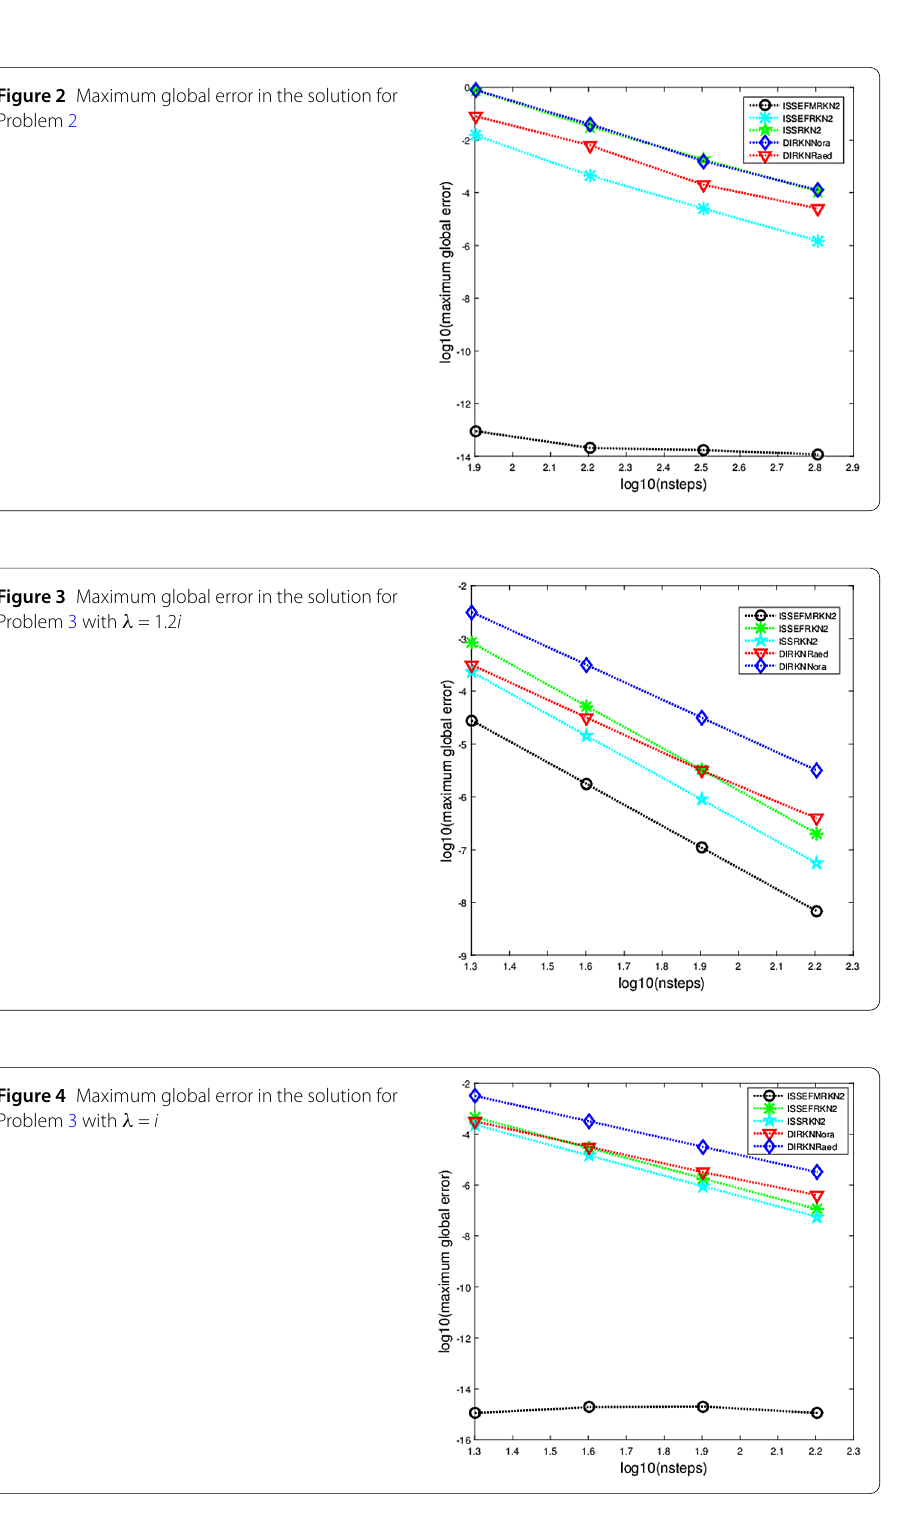
we show the decimal logarithm of the maximum global error (log10(err)) versus the num- ber of steps required by each code on a logarithmic scale (log10(nsteps)). All computa- tions are carried out in MATLAB(Version R2015b), on a notebook computer with Intel Core(TM)i7-2640M CPU (2.80 GHz) and 8 GB